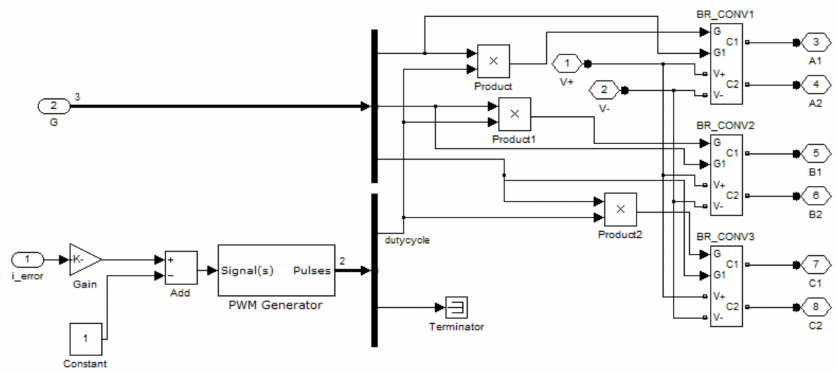
Figure 8. Power converter with PWM generation